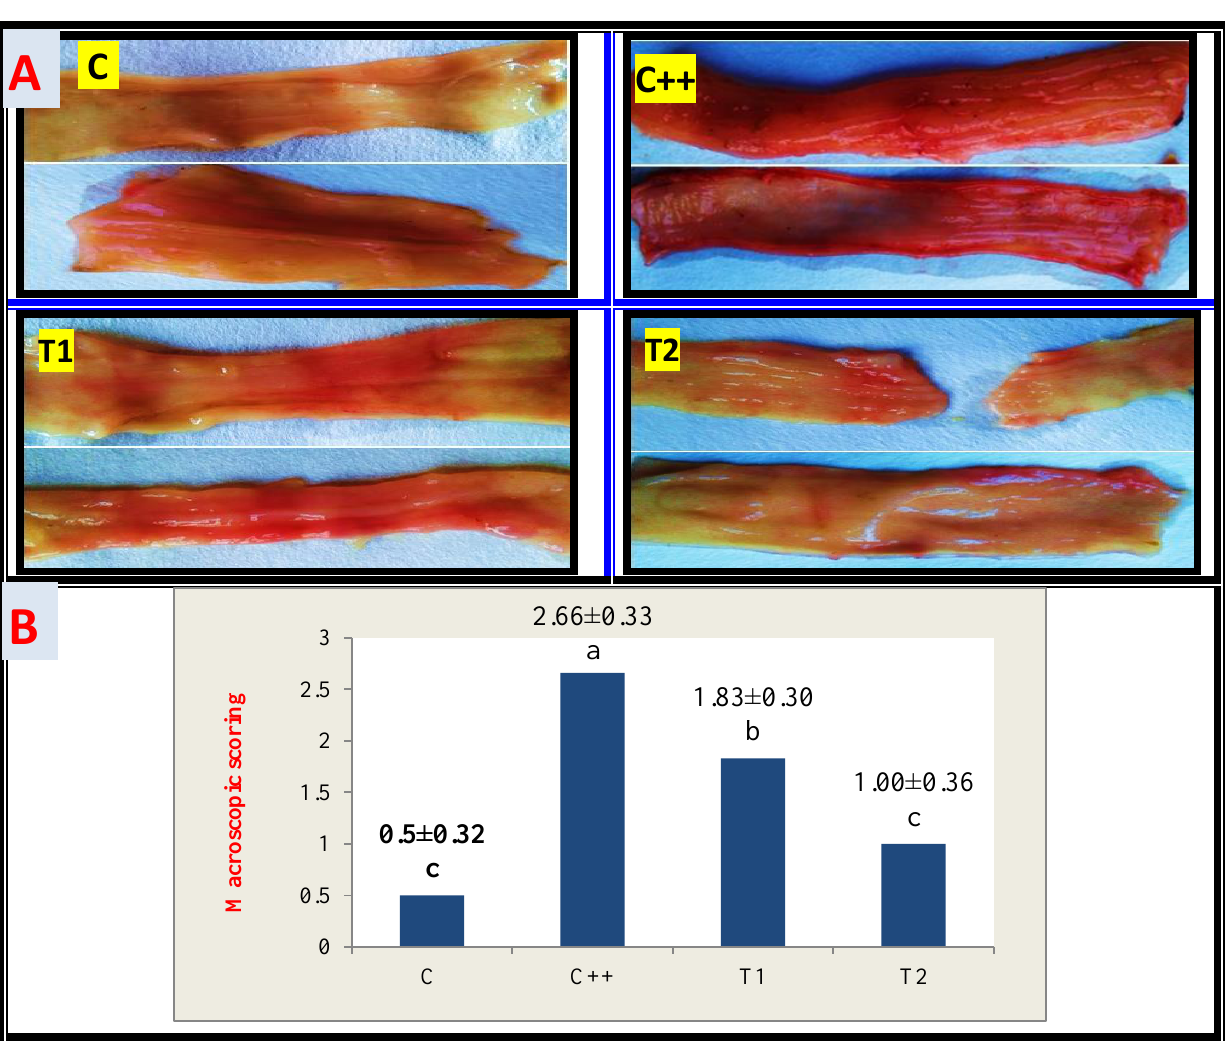
Figure 3. (A) Protective role of synbiotic on gross lesion of colon against E. coli infection. (B) Macroscopic scoring of colitis. C: control negative group. C++: control positive group showing ulcer lesions as pale areas surrounded by hemorrhagic zone, edema, severe blood congestion along the colon with the appearance of rough and marked thickening. T1: Fenugreek administered to enteritis (colitis) group showing small bleeding patches along the colon and the appearance of rough and marked thickening. T2: Fenugreek and L. acidophilus administered to enteritis group, the colon showed clear mucous layer and the appearance of smooth and marked thinning. LSD of macroscopic score=